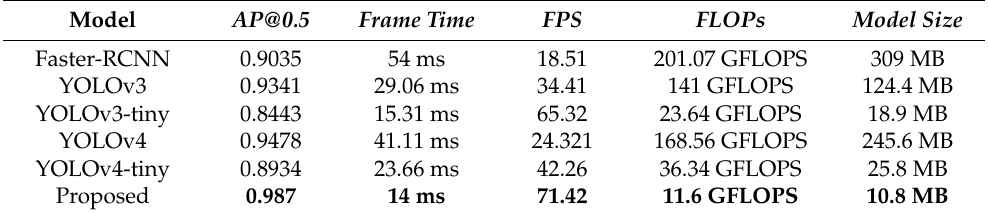
Table 5. Comparison of different models.